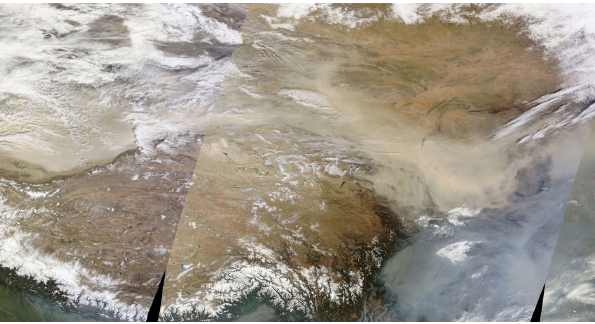
Figure 2. NASA Worldview image for 9 March 2013 (https://go. nasa.gov/2FI0vbI; last access: 21 January